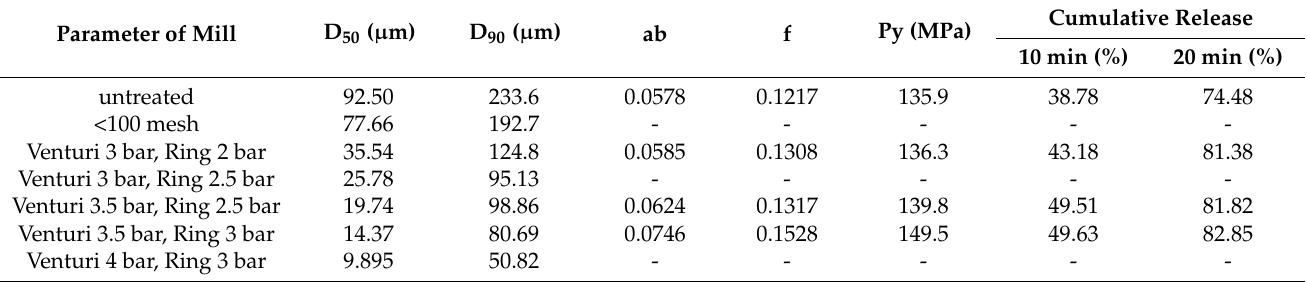
Table 6. Effect of Venturi and Ring pressures during the mill process on HCTZ particles/mixed